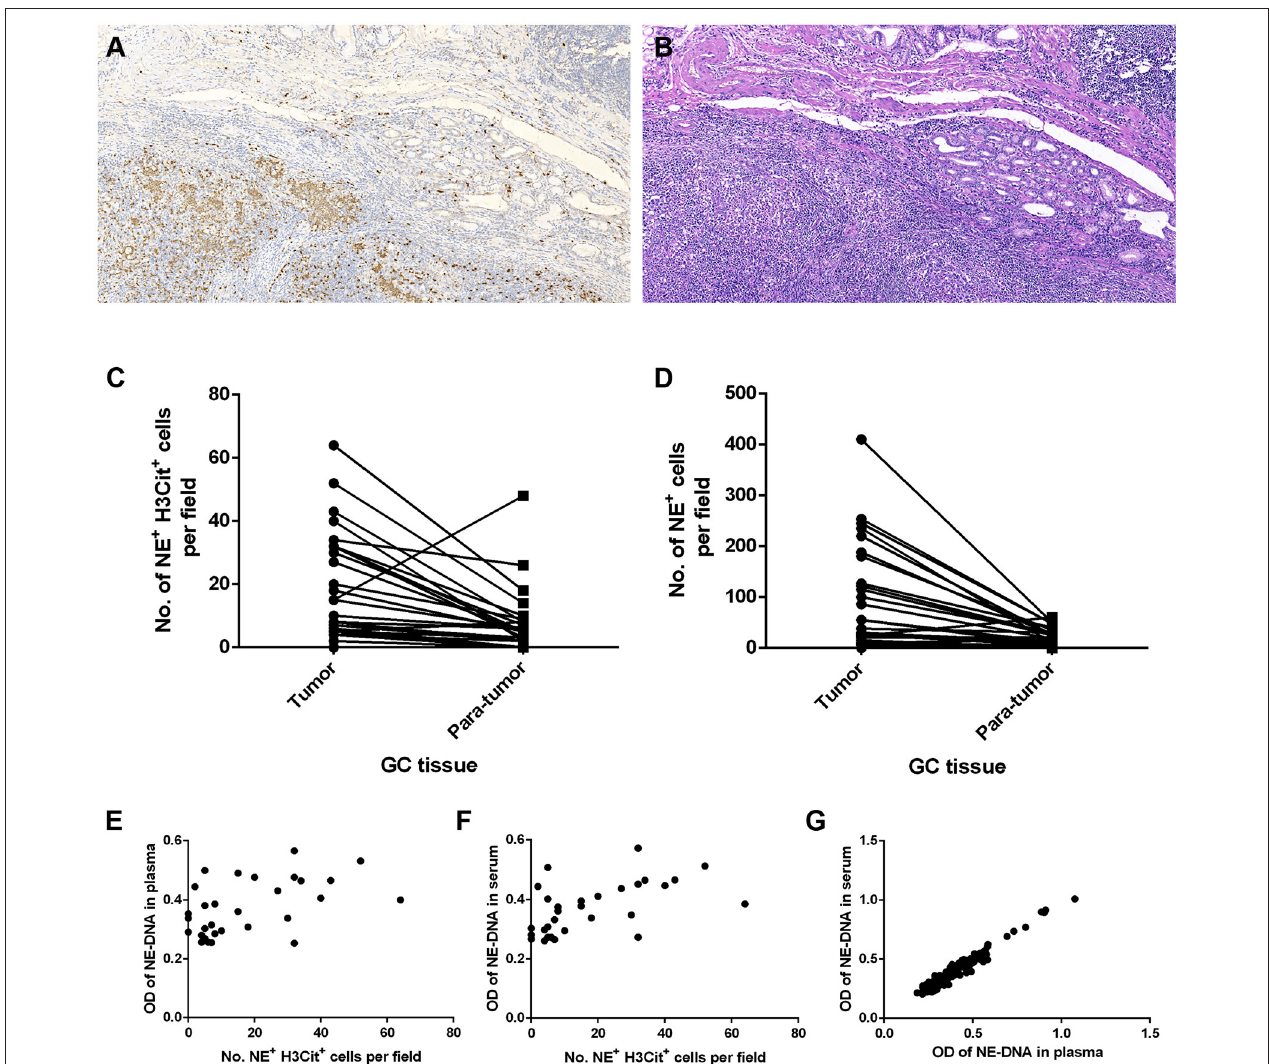
FIGURE 2 | Neutrophil accumulation and neutrophil extracellular traps (NETs) in gastric cancer (GC) tissue and peripheral blood (PB) components collected from patients. (A) Immunohistochemical staining for neutrophil elastase (NE) in GC. (B) H&E staining of GC tissue. (C) Reduced median numbers of NET formations per field in paratumor tissue samples compared with tumor tissue samples ( P < 0.001). (D) Decreased neutrophil accumulation in paratumor tissue samples compared with tumor tissue samples ( P < 0.001). (E,F) Statistically significant correlations between the formation of NETs in tumor tissue samples and that in the components of PB samples ( E : tissue and plasma, r = 0.456, P = 0.011; F : tissue and serum, r = 0.580, P = 0.001). (G) Statistically significant correlation between the formation of NETs in plasma and that in serum ( r = 0.973, P < 0.001). Original magnification: 100x (A,B) .